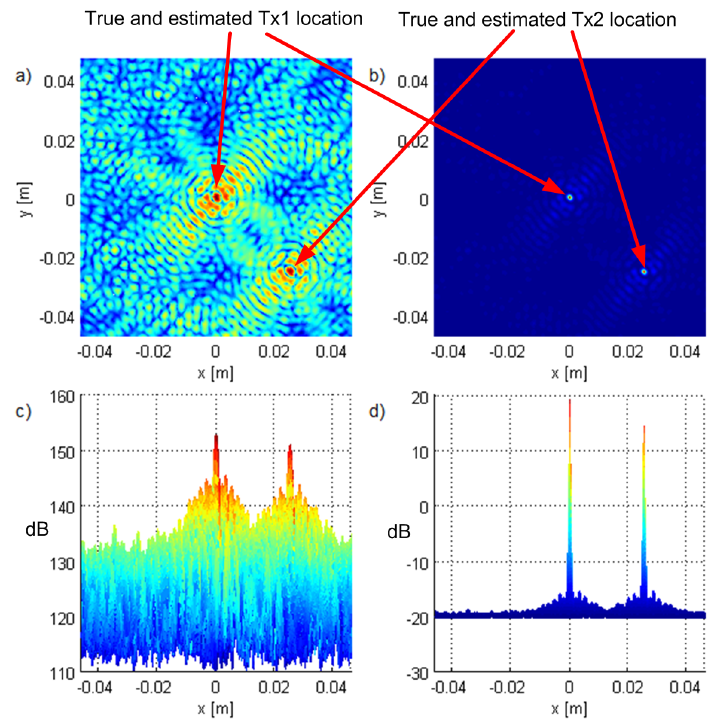
Figure 17. Experiments with two transmitters in LoS and with equal powers: top views of the criterion functions for G 90 and T 1 for ( a ) ML-US, ( b ) SCM-MUSIC, and the corresponding side views in ( c , d ) with the magnitude in